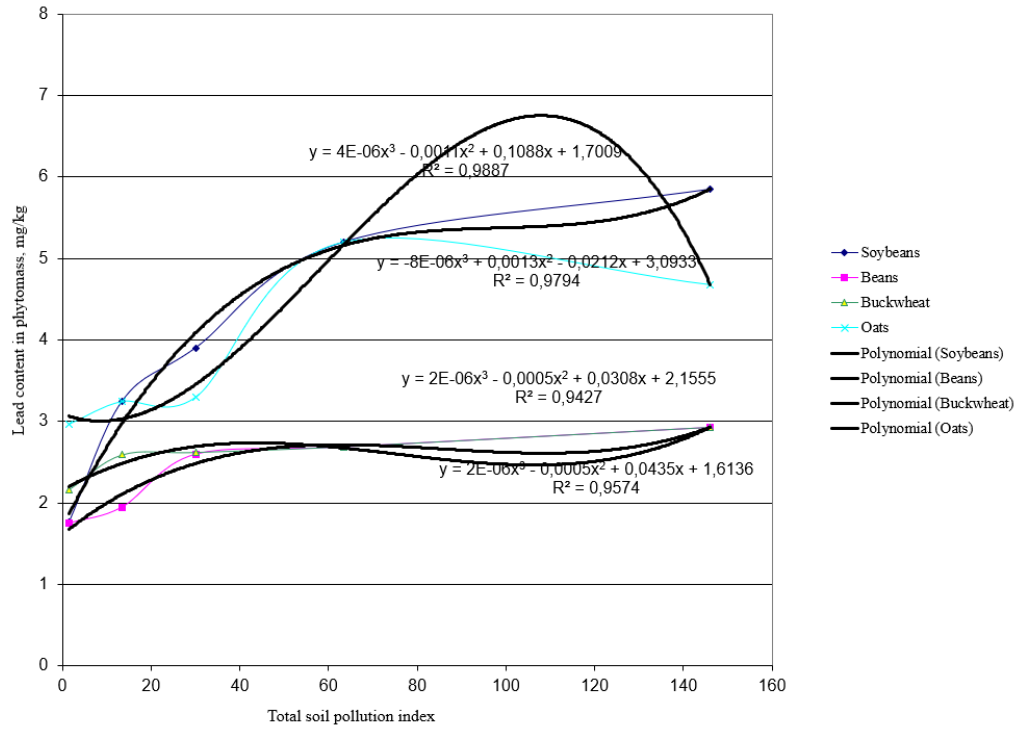
Figure 7. Dependence of lead content in plant phytomass on the level of soil contamination.